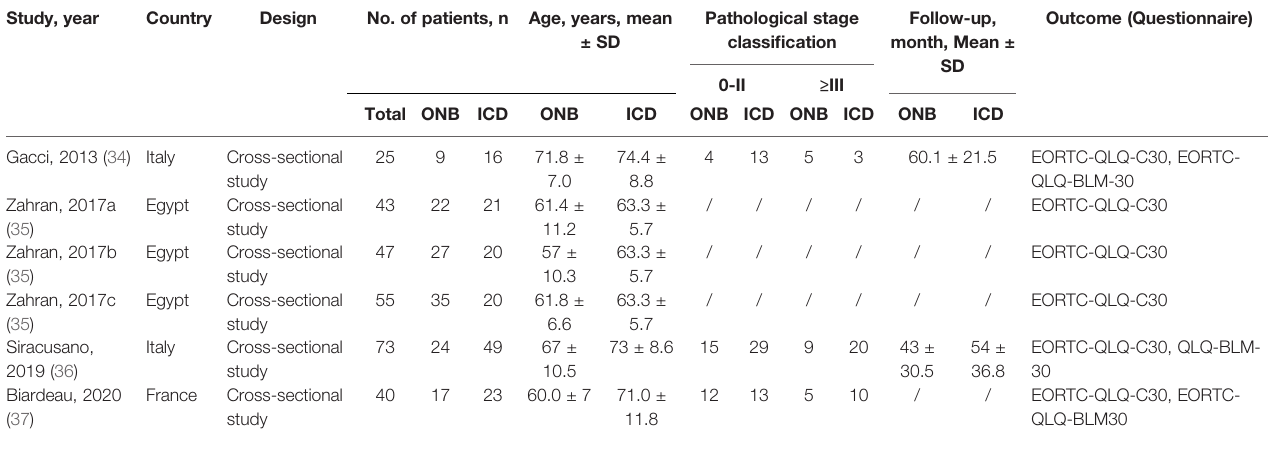
TABLE 1 | Literature search and characteristics of the included